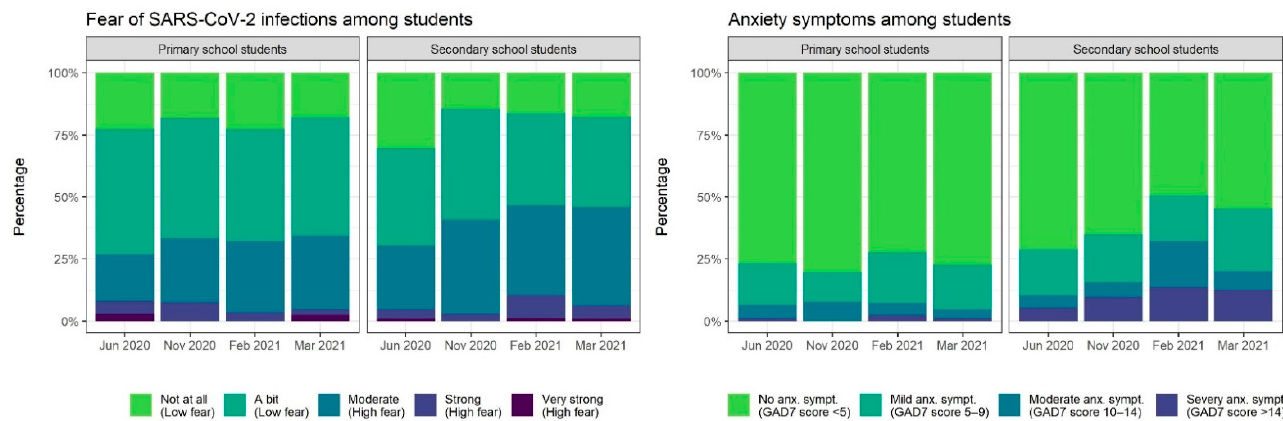
Figure 2. Fear of SARS-CoV-2 infection and anxiety among Berlin school children; June 2020 to March 2021.